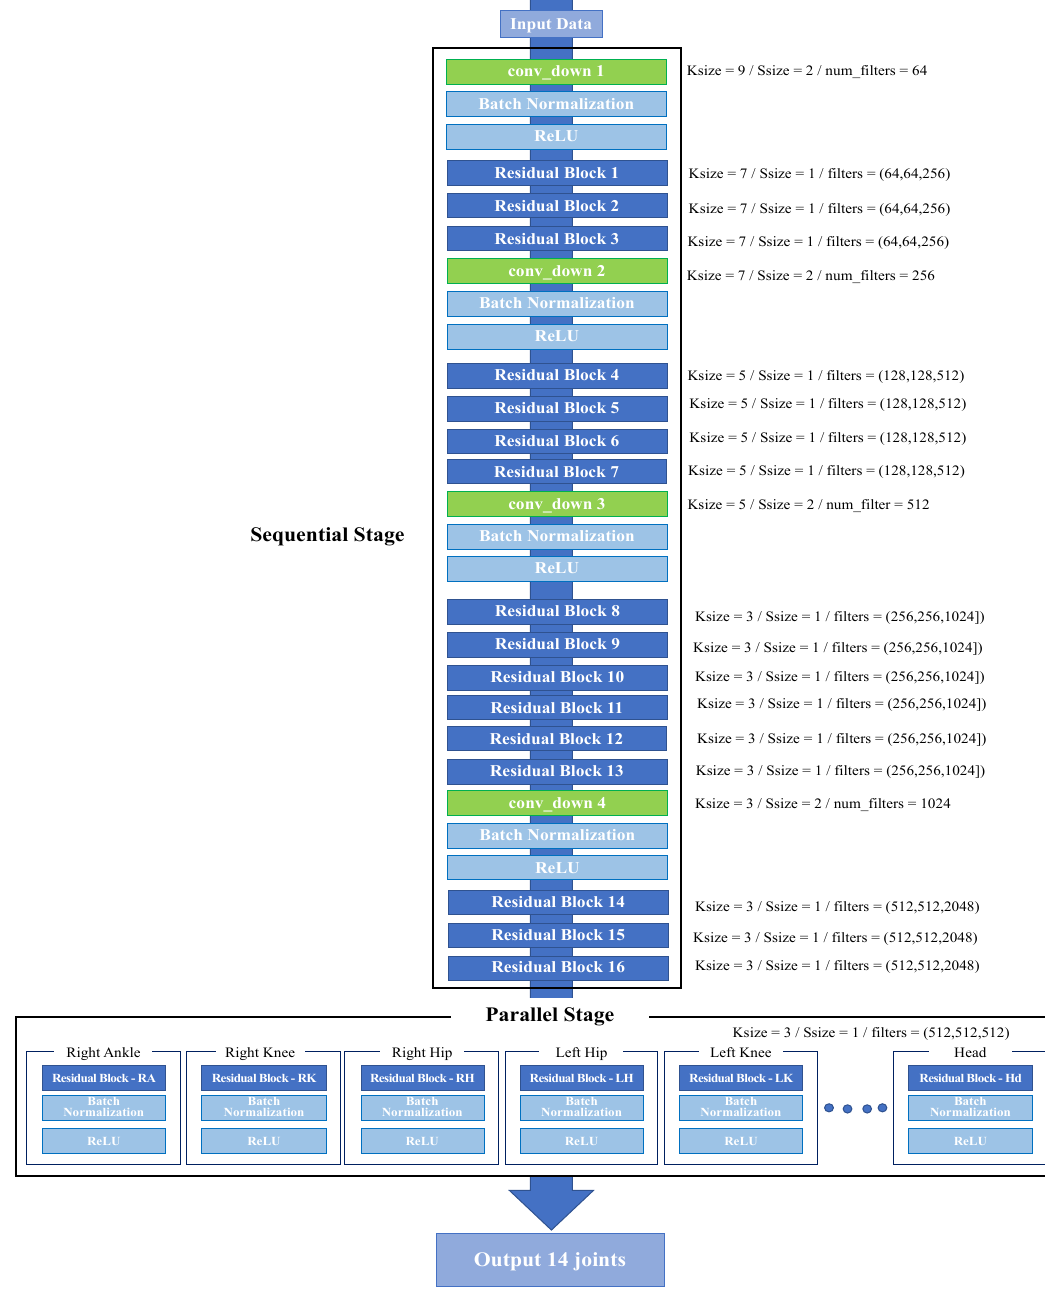
Figure 5. The structure of proposed deep neural network (DNN) model for activity estimation. In the training of the model, the training data were augmented using various geometric transforms. Of the total 870 images, 696 images (80%) and joint coordinates were used for training, using stratified sampling that maintained the same proportion of each activity. After shuffling and pixel normalization, augmentation was performed with (1) rotation, (2) vertical flipping, and (3) random cropping. The rotation process increased the amount of training data by a factor of 11 by rotating an image by 5° at a time within the range of − 30° to 30°, increasing twice using a vertical flip (flipping the left-hand and right-hand sides of an image around the center line of the image), and performing random cropping, by which an image with a person was scaled to various sizes and translations. To apply random cropping, a bounding box was set-up in an image including all human joint coordinates tightly. The four-sided gaps around the tight bounding box from the original image